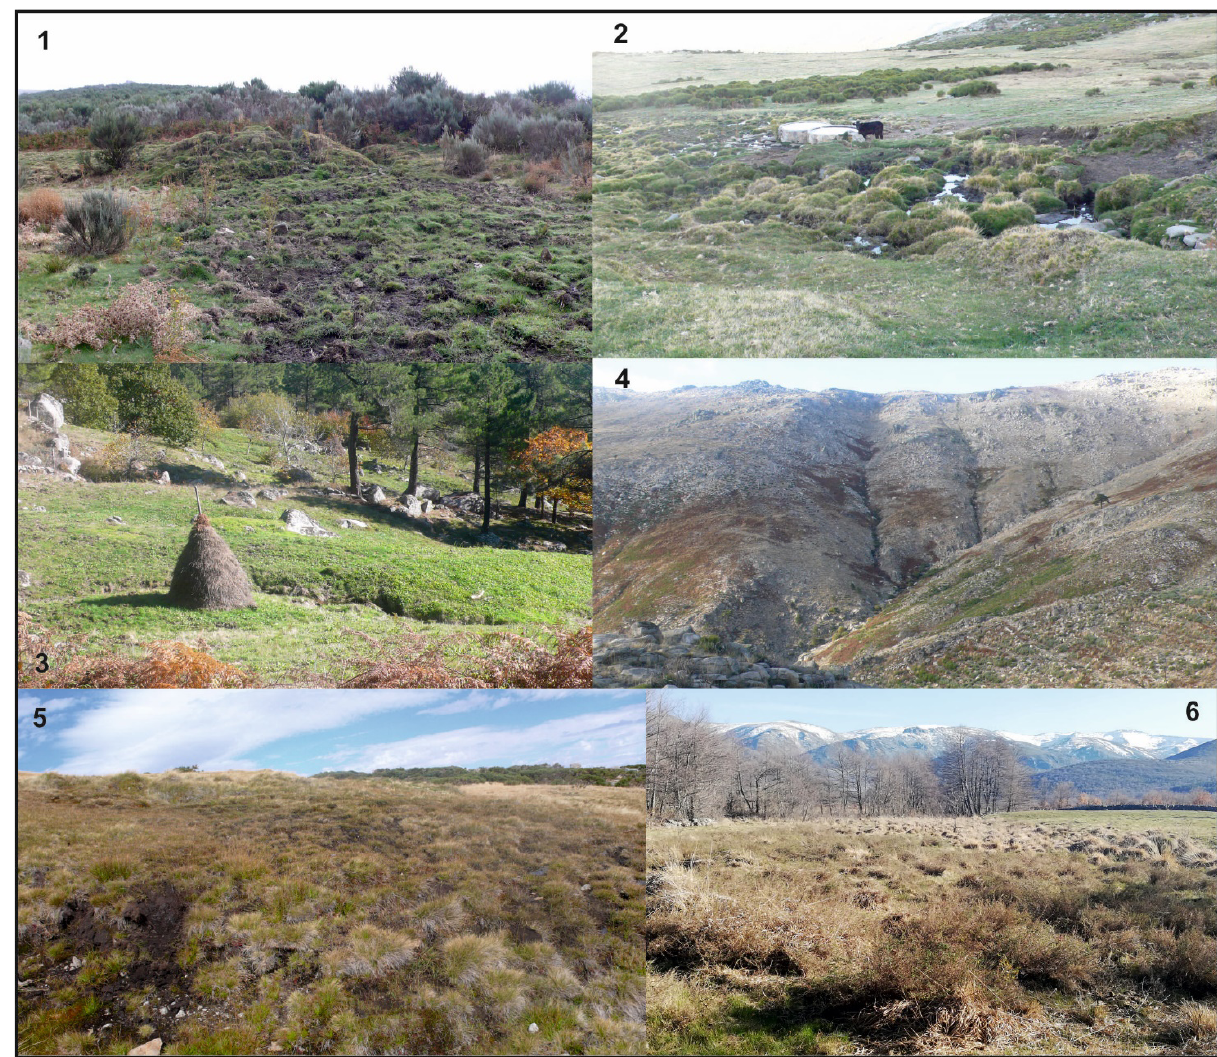
Figure 3. Unconfined peatland typological groups according to t eir geomorphological location and the origin of the landform (see Table 1): SP-type (1, Manantial de las Queseras; 2, Refugio del Barquillo); TT-type (3, Arroyo de Aguas Frías; 4, Arroyo de los Herreros S and N; 5, Fuente de los Cavadores W; 6,